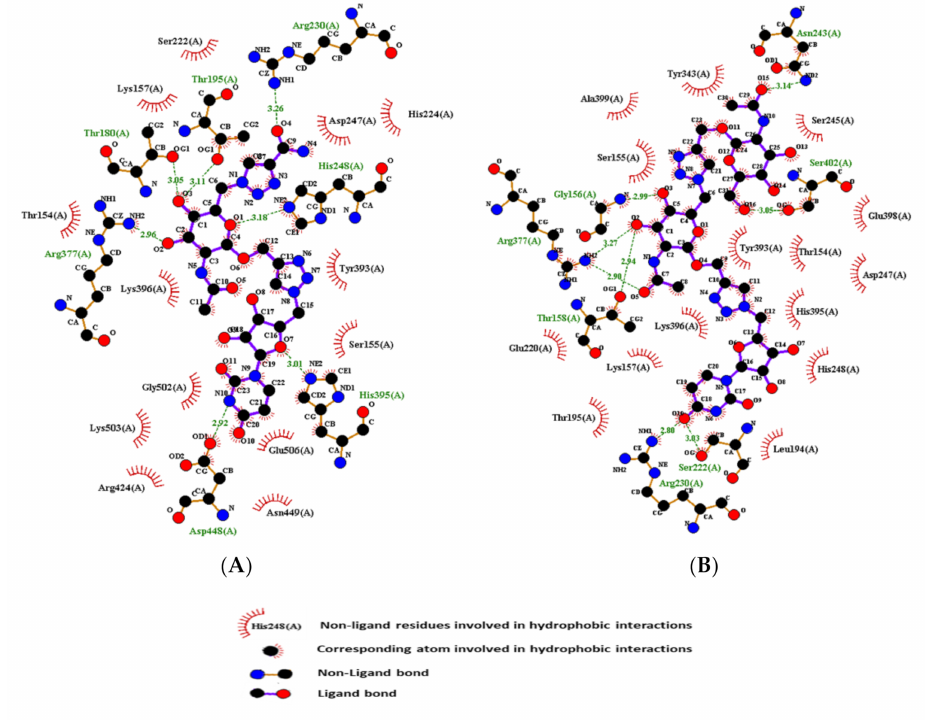
Figure 2. Hydrogen bonds and hydrophobic interactions between Mtb MurE and 11c ( A ) and 11e ( B ), respectively. The green dotted lines depict the hydrogen bonds whereas the other residues represent the hydrophobic interactions with the respective